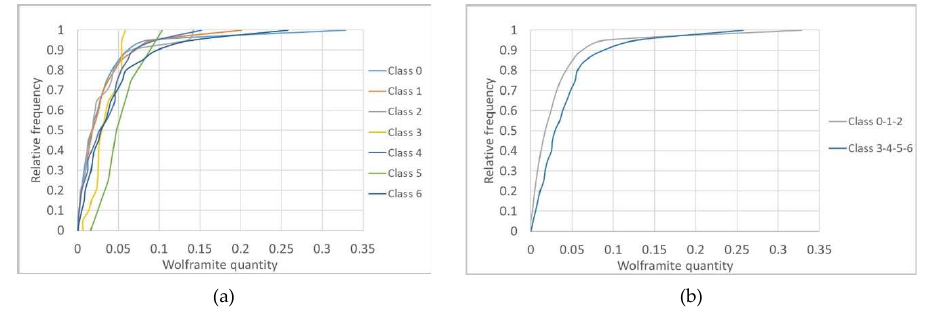
Figure 10. Conditional cumulative histograms for L0: ( a ) for each class and ( b ) for grouped classes.